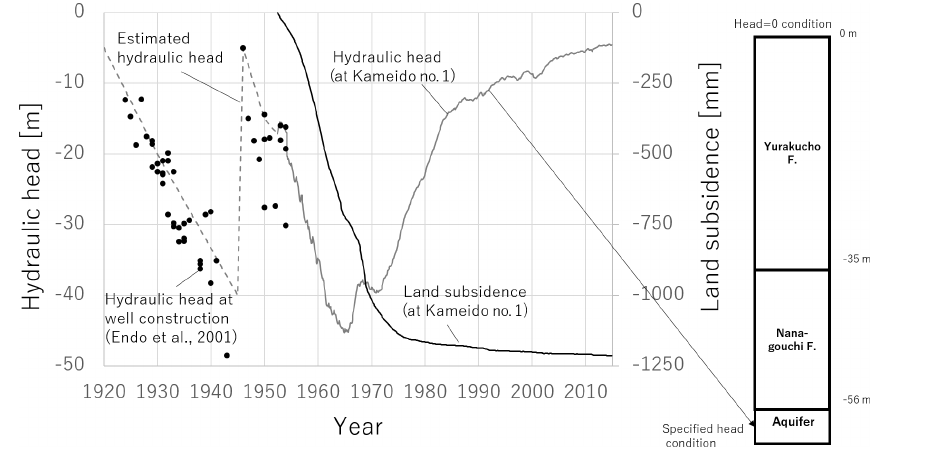
Figure 2. Observed data and model settings for a test at Kameido in Tokyo lowland, Japan.